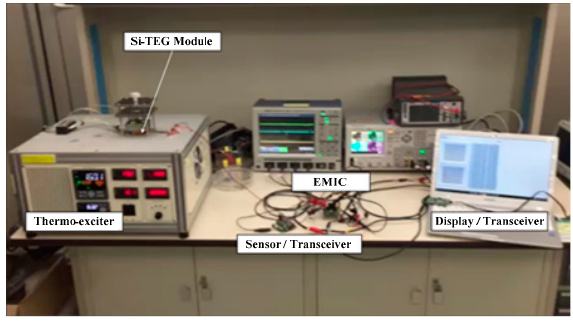
Figure 15. The experimental set-up for verifying the feasibility of the proposed wireless sensor node system.